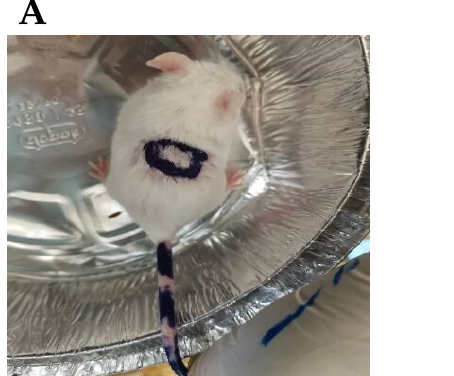
Figure 7. The skin lesions induced by DMBA in male mice. ( A ) A sample of the lesions in the vehicle group. ( B & C ) Measuring the dimensions of the lesions in a mouse from the DMBA+vehicle group. Dimensions were measured by a caliber adjusted at the edges of the lesion.